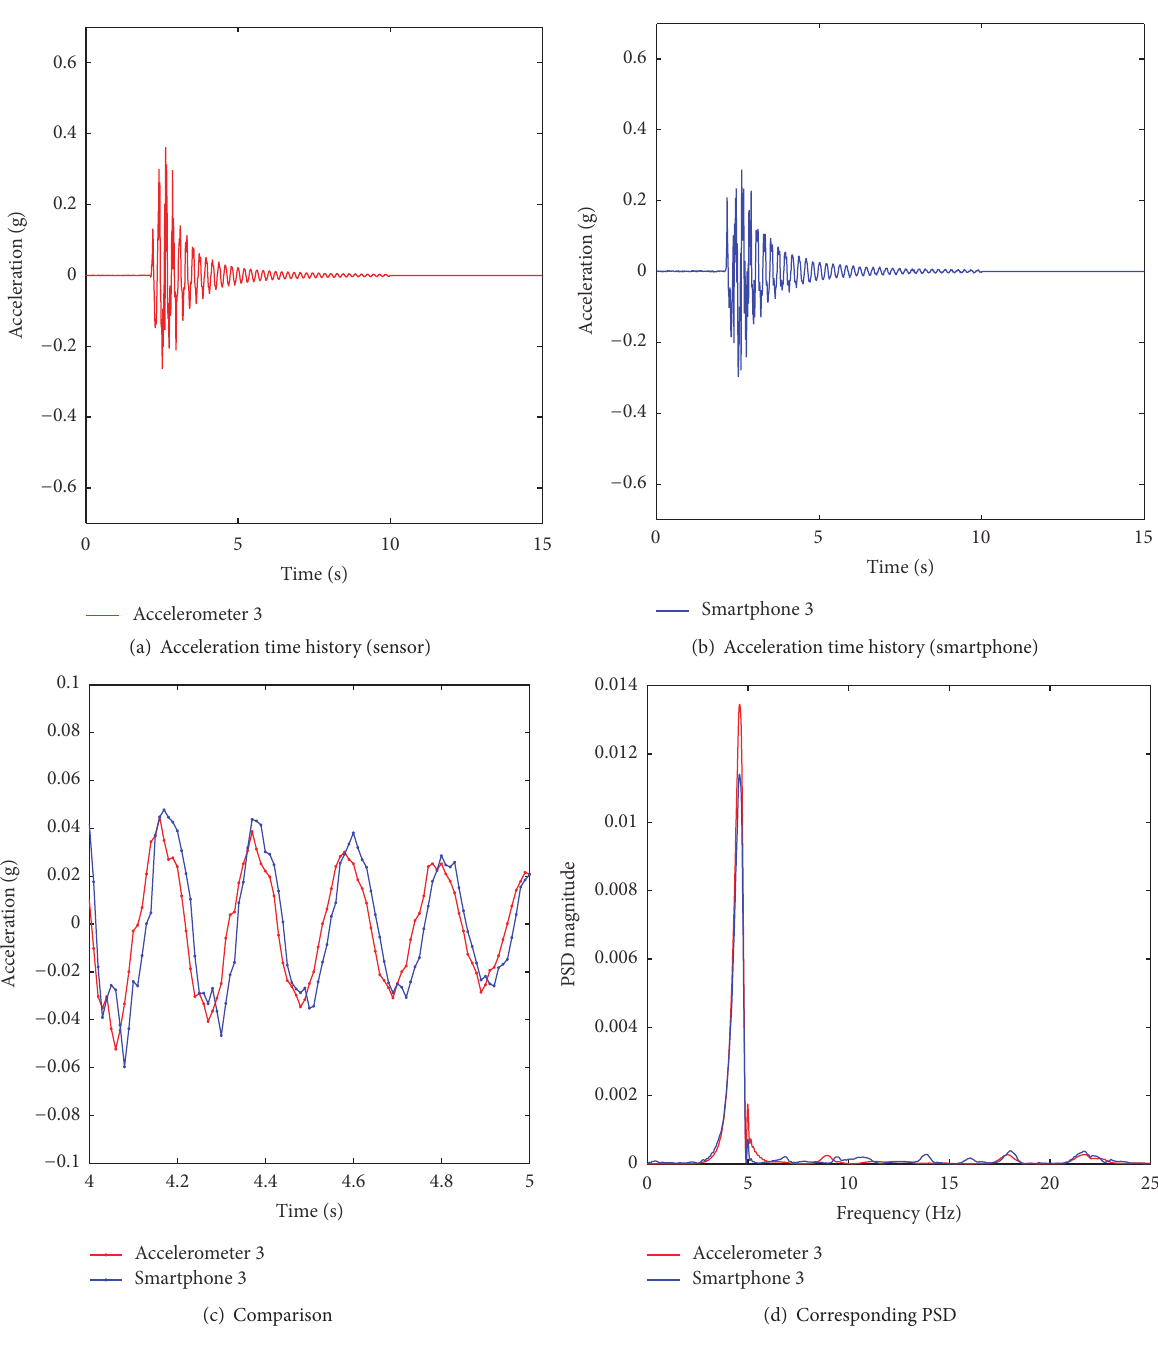
Figure 14: Acceleration measurements (right quarter